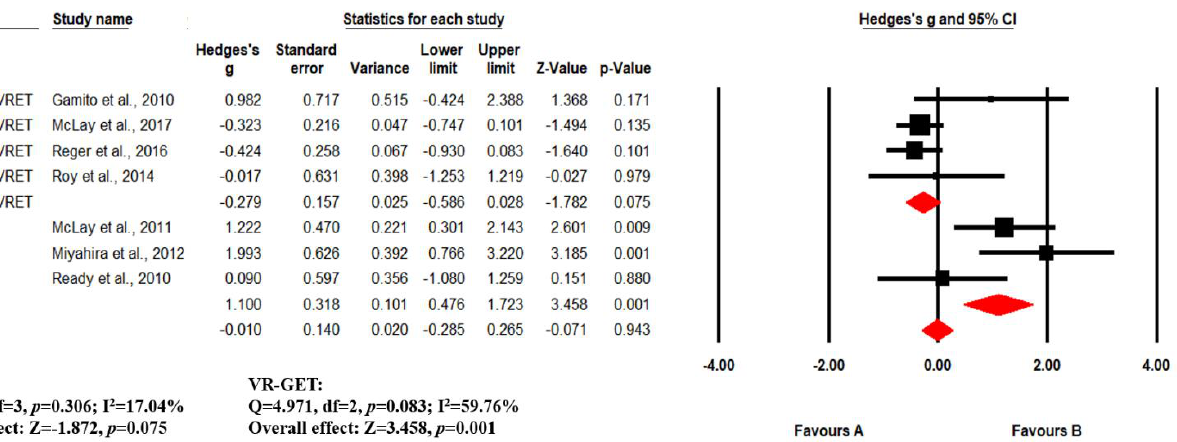
Figure 3. Forest plot demonstrating the efficacy of VR-based exposure therapy on PTSD symptoms.